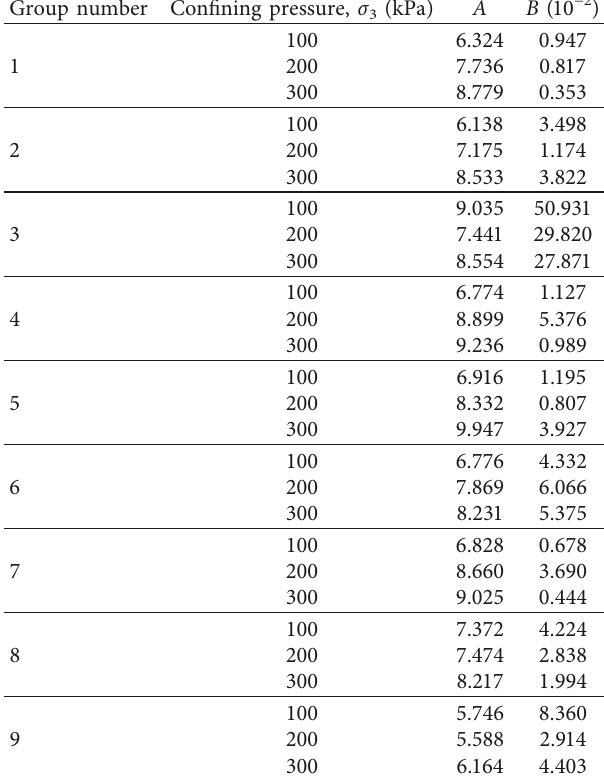
Table 2: Obtained values of A and B . Group number Confining pressure, σ 3 (kPa) A B (10